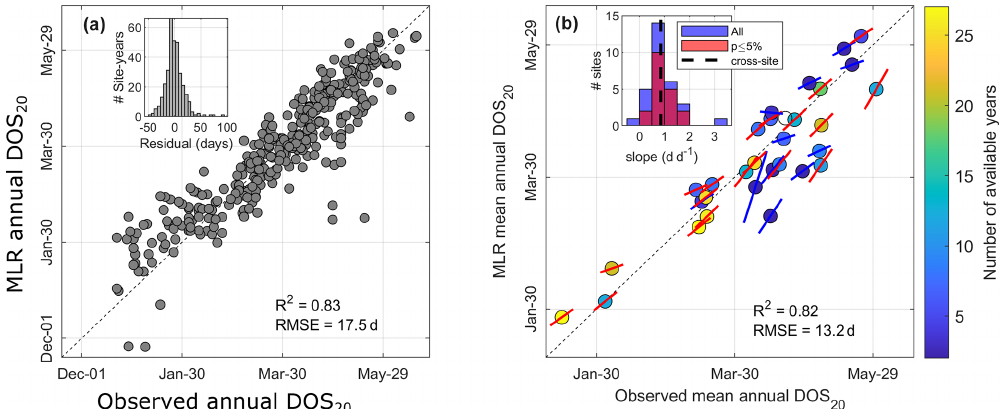
Figure 7. (a) Scatterplot showing the fit of the stepwise multiple linear regression (MLR) model to the observed DOS 20 across all sites and years. Panel (b) shows the same stepwise MLR model applied at the mean annual watershed level across all watersheds. Interannual variability represented by the slope of the linear relationship is shown as a line overlapping each circle (i.e., watershed); red and blue lines indicate statistically significant ( p ≤ 0 . 05) and insignificant slopes,